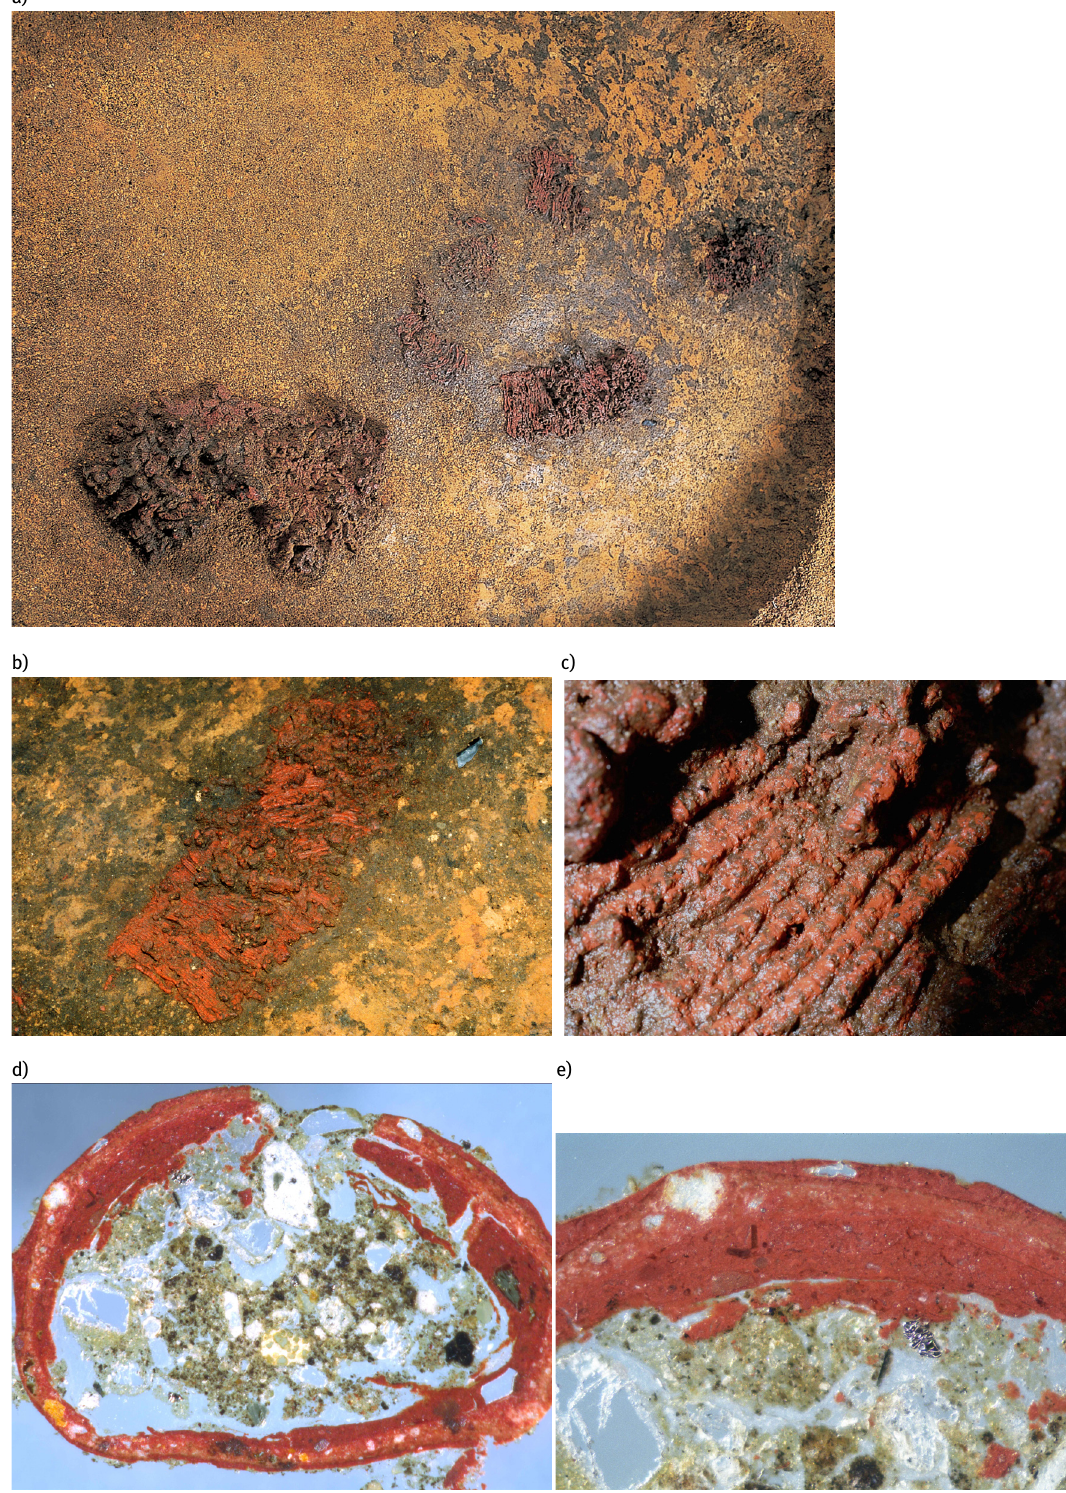
Figure 3. Lacquered strings excavated from Kakinoshima B site, Hokkaido a) Excavated state, b) Lacquered strings on the left shoulder of the buried person, c) Close-up of the excavated state, d) and e) Microphotographs of the section of a lacque- red string. Photographs kindly provided by Hakodate City Board of Education (a, b) and Masaharu Nagashima (c, d, e) with